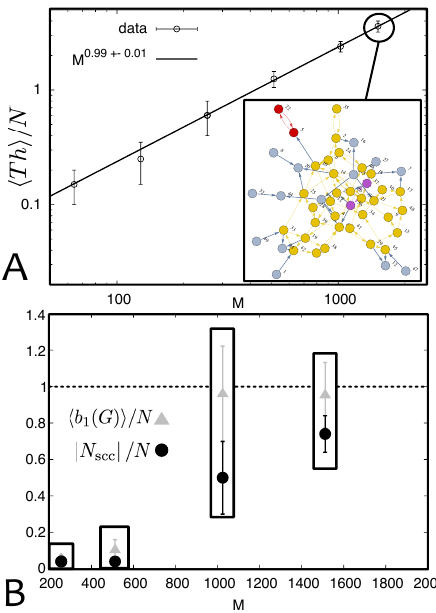
Figure 6. ( A ) Threadings can be directly detected through the algorithm described in the text. The number of threadings in the system is found to grow linearly with the size of the rings. (Inset) The proliferation of threadings can be seen as forming a network of constraints, here captured by a graph G with directed edges pointing to actively threaded rings. The different colors identify different connected components of the graph. ( B ) The network can be quantified by measuring the Betti number (cid:104) b ( G ) (cid:105) and the size of the largest strongly connected component | N scc | . These are observed to sharply 1 increase around M (cid:39) 1000 and the fraction of rings | N scc | / N → 1 at large M , indicating that the network of threadings percolates through the whole